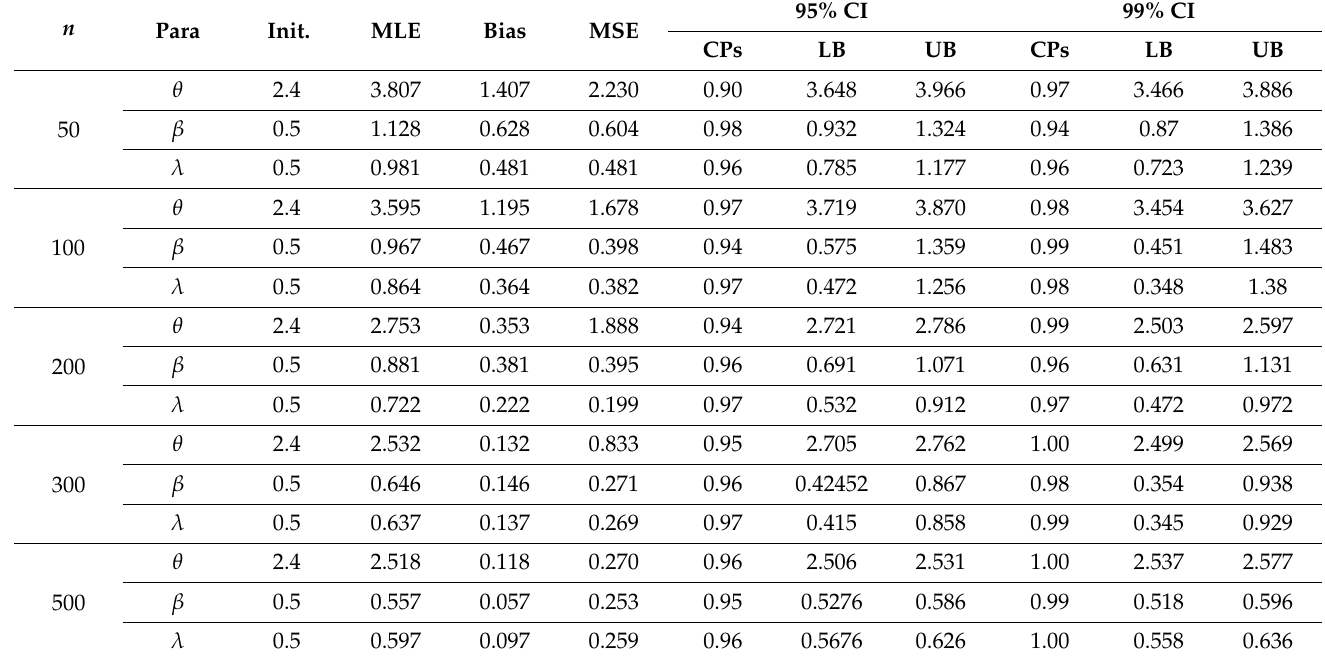
Table 3. The MLEs, Bias, MSE, CPs for the model parameters of the minLLx distribution based on some initial (Init)